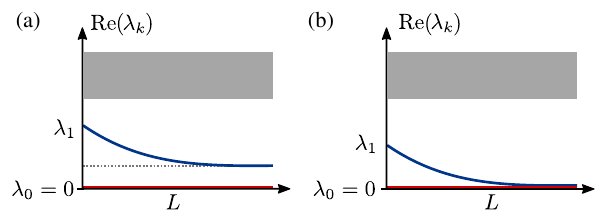
FIG. 2. Generic spectrum of relaxation (damping) rates as a function of system size L for (a) a metastable system and (b) a truly bistable